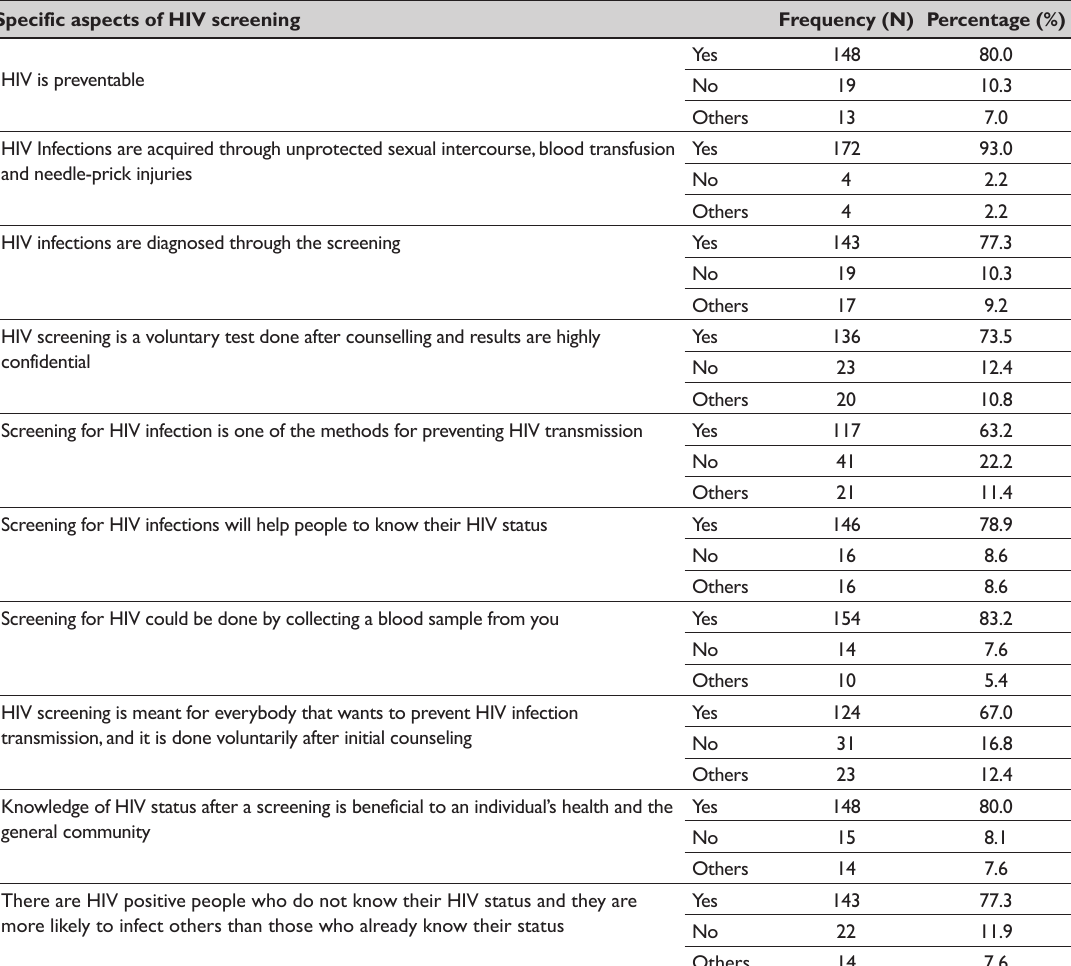
Table 3: Perceived knowledge of specific aspects of HIV screening Specific aspects of HIV